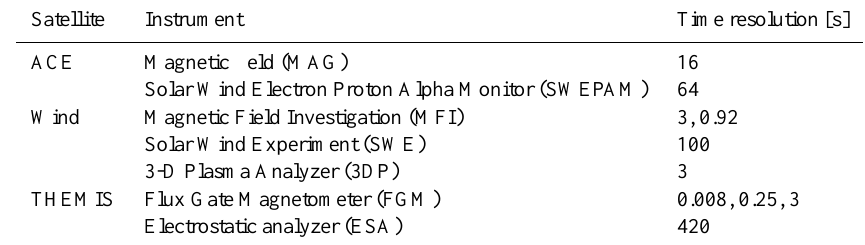
Table 1. Table summarizes the satellites, instruments, and their available time resolutions used in this study. Satellite Instrument